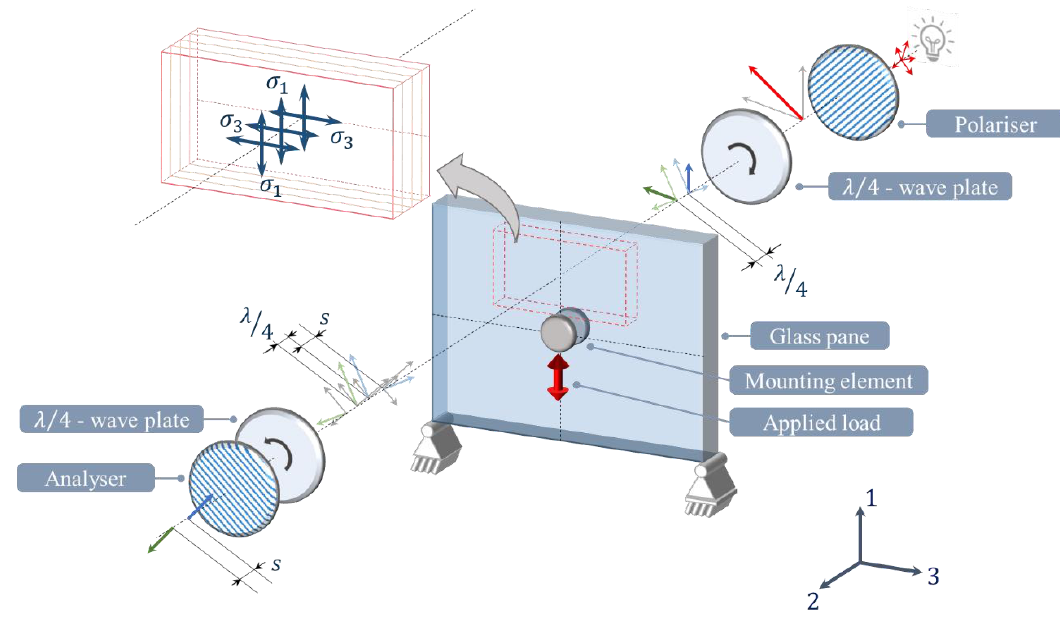
Fig. 1 Schematic illustration of a circular polariscope including polariser, analyser and two quarter-wave